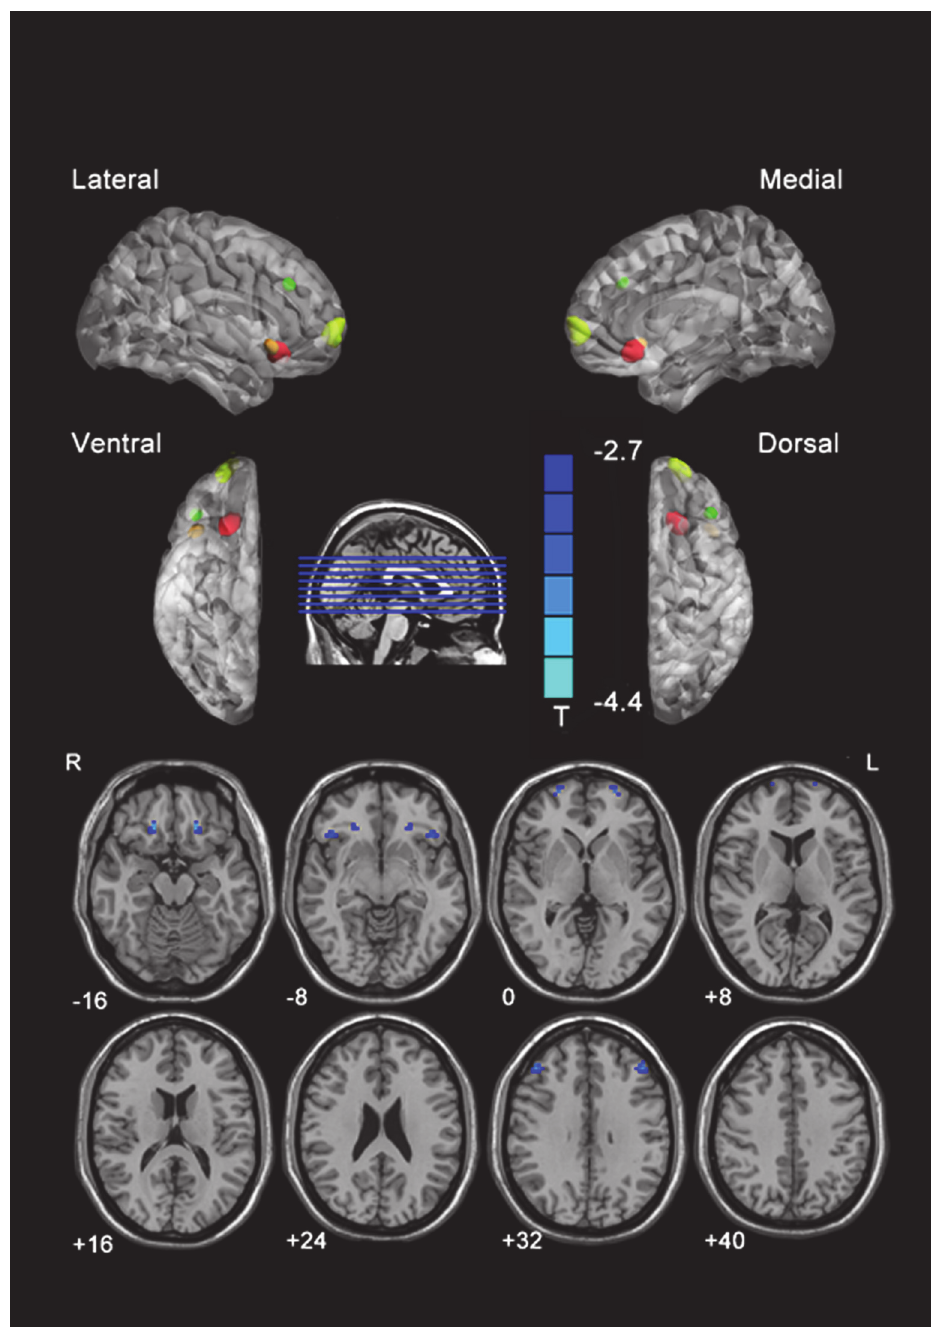
Fig 1. Statistical maps showing VMHC differences between participants with IGD and healthy participants. Blue denotes lower VMHC and the color bars indicate the T value from the t test between groups. In the upper part of the picture, colors represent areas of the brain: red, represents the left and right superior frontal gyrus (orbital part); orange, inferior frontal gyrus (orbital part); yellow, middle frontal gyrus; green, superior frontal gyrus. VMHC, voxel-mirrored homotopic connectivity; IGD, Internet gaming disorder. Note: The left part of the figure (L) represents the participant ’ s left side, (R) represents the participant ’ s right side.